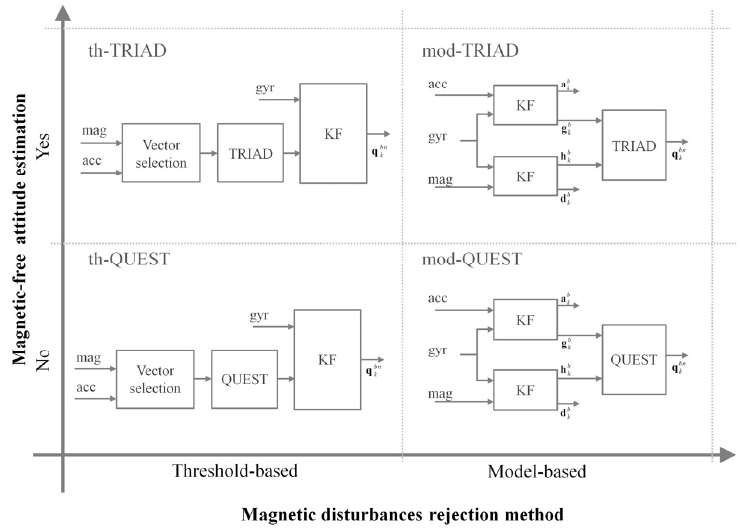
Figure 3. Methods considered in this work for an experimental comparison. The algorithms presented in [35] and [9] were taken as representatives of the threshold ‐ based and the model ‐ based approaches, respectively. Then, they were combined with the TRIAD and QUEST single ‐ frame methods in order to span all the possible